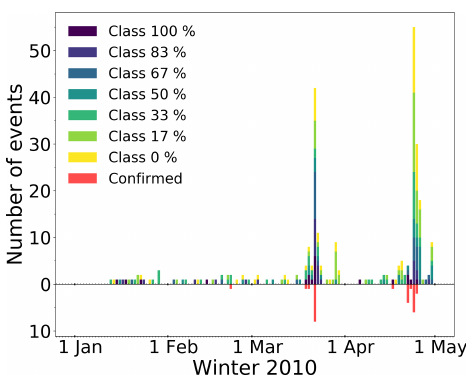
Figure 3. Avalanche activity for the winter season of 2010. The different colors above the zero line indicate the different probability classes derived from the manual detection. The red bars below the zero line indicate the visually confirmed events.